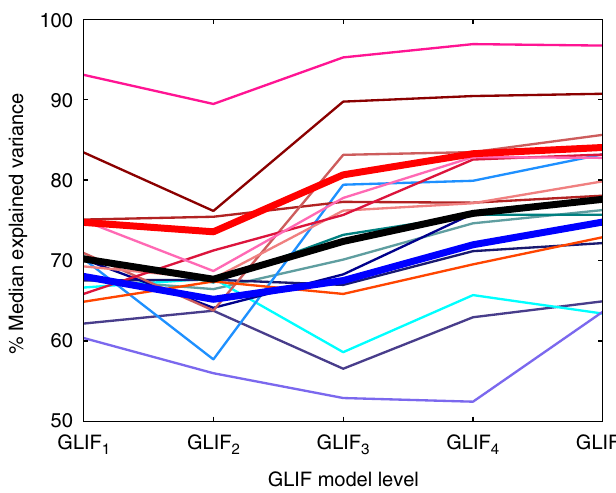
Fig. 5 Different mechanisms improve model performance for inhibitory and excitatory neurons. The traditional leaky integrate and fi re model ( GLIF 1 ) yielded surprisingly high model performance. Overall, inhibitory models were more successful at reproducing spike times than excitatory models. Reset rules implemented on their own ( GLIF 2 ) decreased model performance. After-spike currents ( GLIF 3 ) improved inhibitory model performance, whereas a combination of both after spike currents and reset rules ( GLIF 4 ) were required to gain performance of excitatory models. The voltage-dependent adapting threshold ( GLIF 5 ) improved performance of excitatory models even more, but had only a slight effect on inhibitory models. The thick blue line denotes all excitatory neurons, the thick red line denotes all inhibitory neurons, and the thick black line is for all neurons. Thin lines are different transgenic lines. Accompanying data is available in Table 3. p -values for signi fi cant differences between GLIF model levels can be found in Supplementary Figures 8, 9, and 10. Brie fl y, for the “ all ” , “ excitatory ” , and “ inhibitory ” groupings the p -values are smaller than 0.01 (and often much smaller) for all but between the excitatory GLIF 2 and GLIF 3 (Supplementary Fig. 8). Differences between GLIF levels of different transgenic lines are sometimes statistically signi fi cant and sometimes